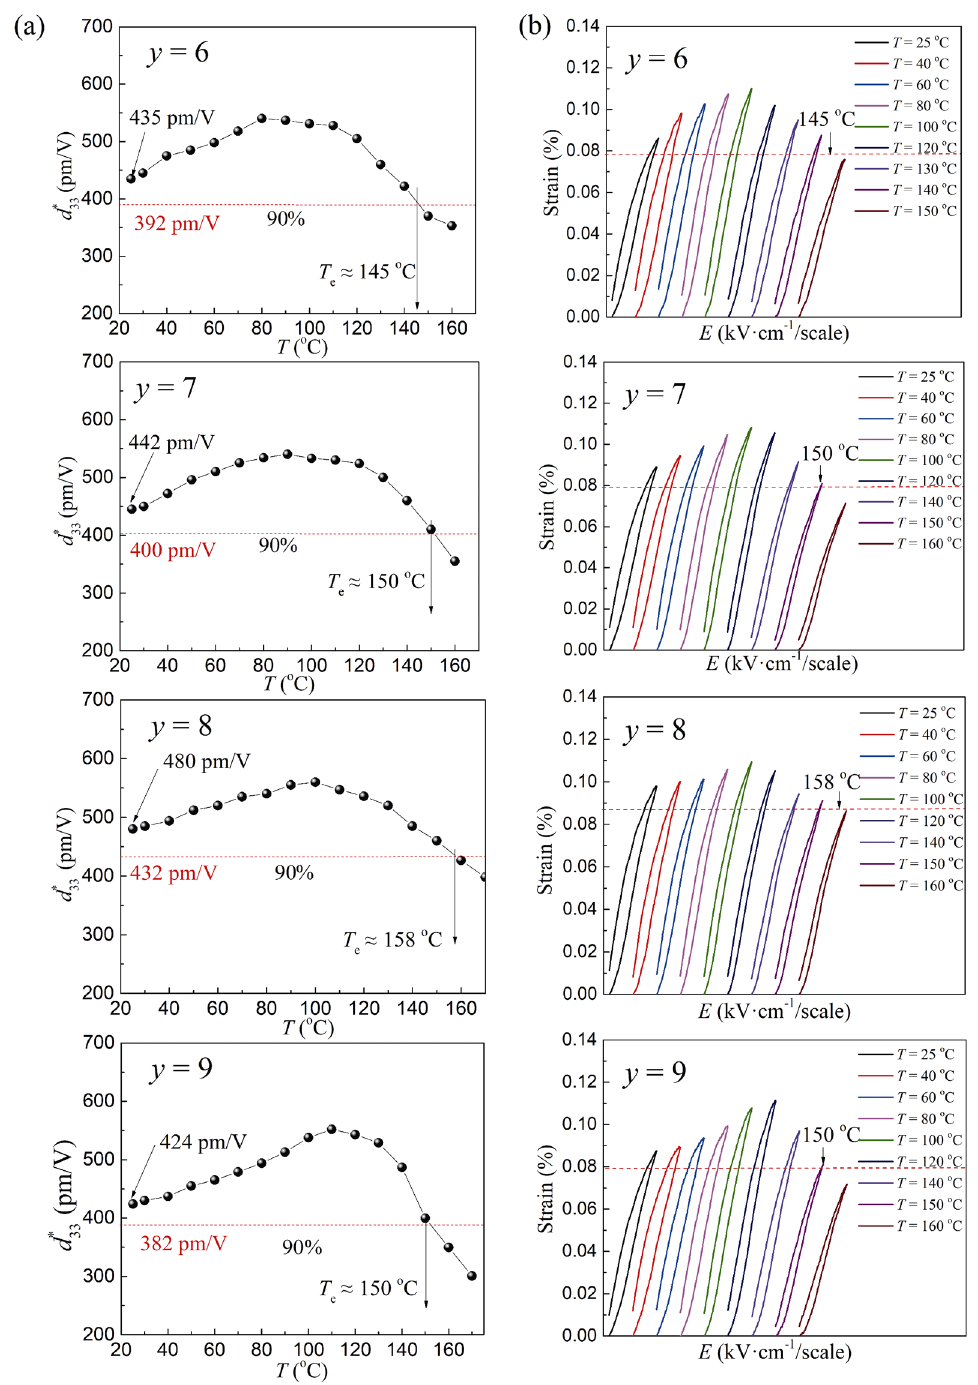
d and (b) temperature dependence of representative unipolar strain curves for the Fig. 7 (a) Temperature dependence of * 33 poled KNNT–0.055BZ + 0.03Zr + y Mn